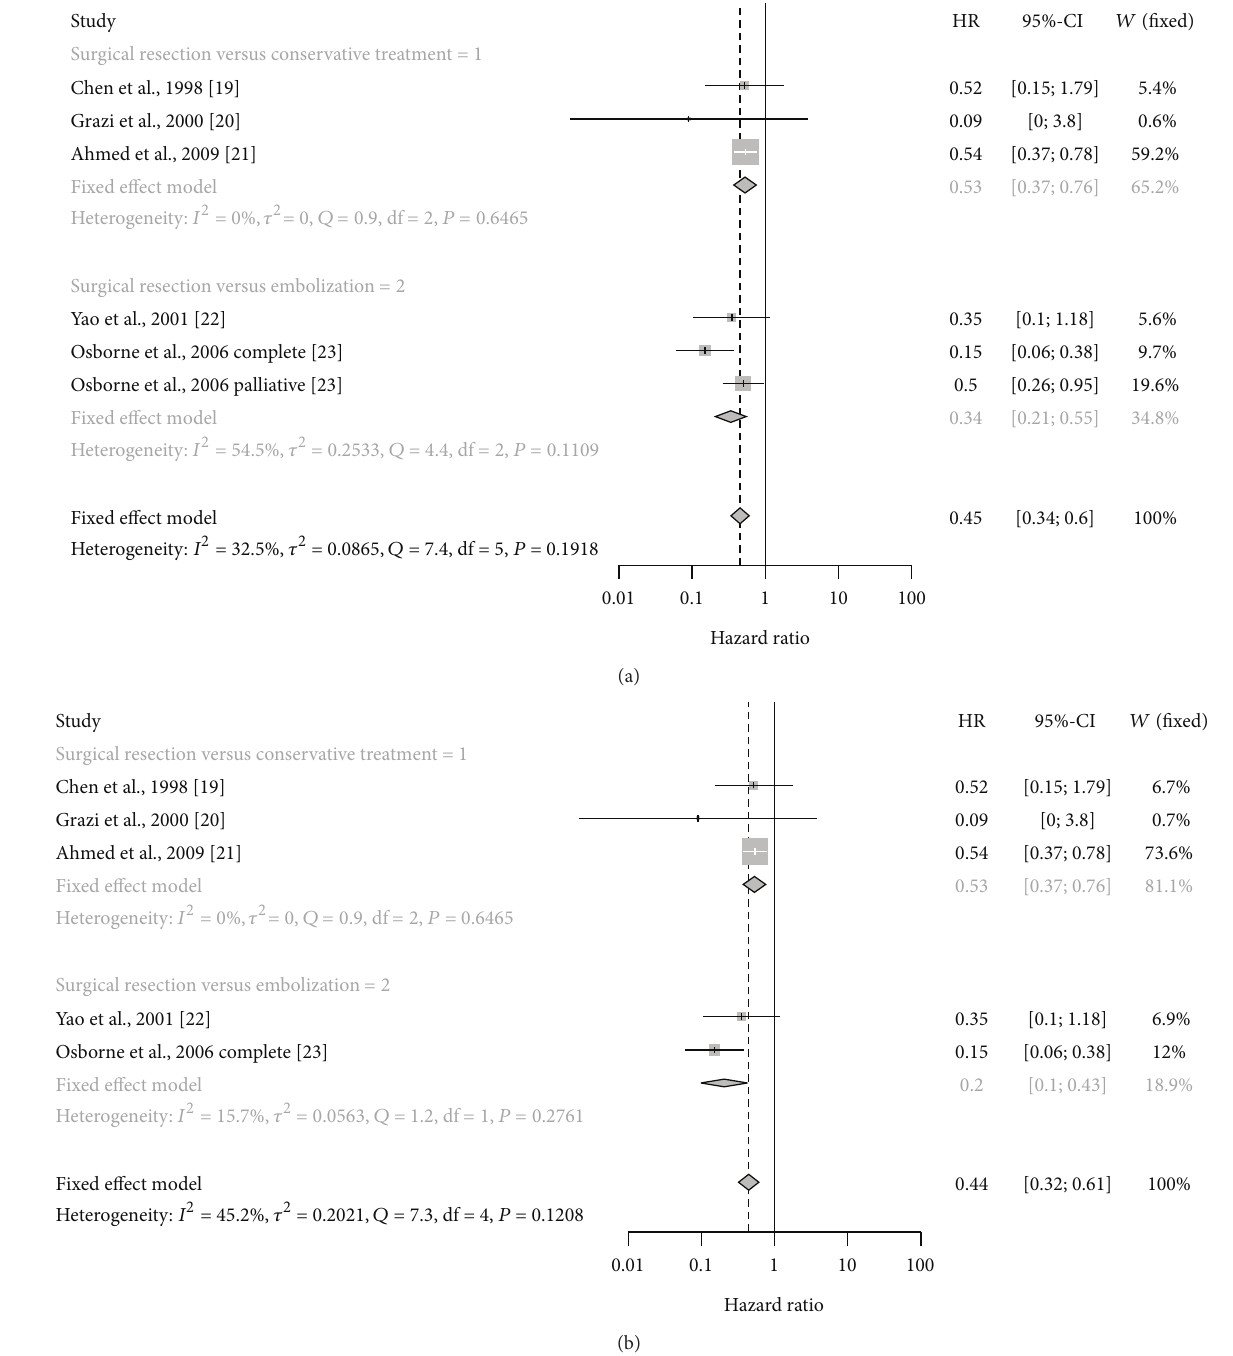
Figure 2: (a) Forest plot of overall survival comparison between hepatic metastasis resection versus expectant or other conserva- tive/minimally invasive managements. (b) Analysis of OS excluding palliative surgery from data published by Osborne et al.